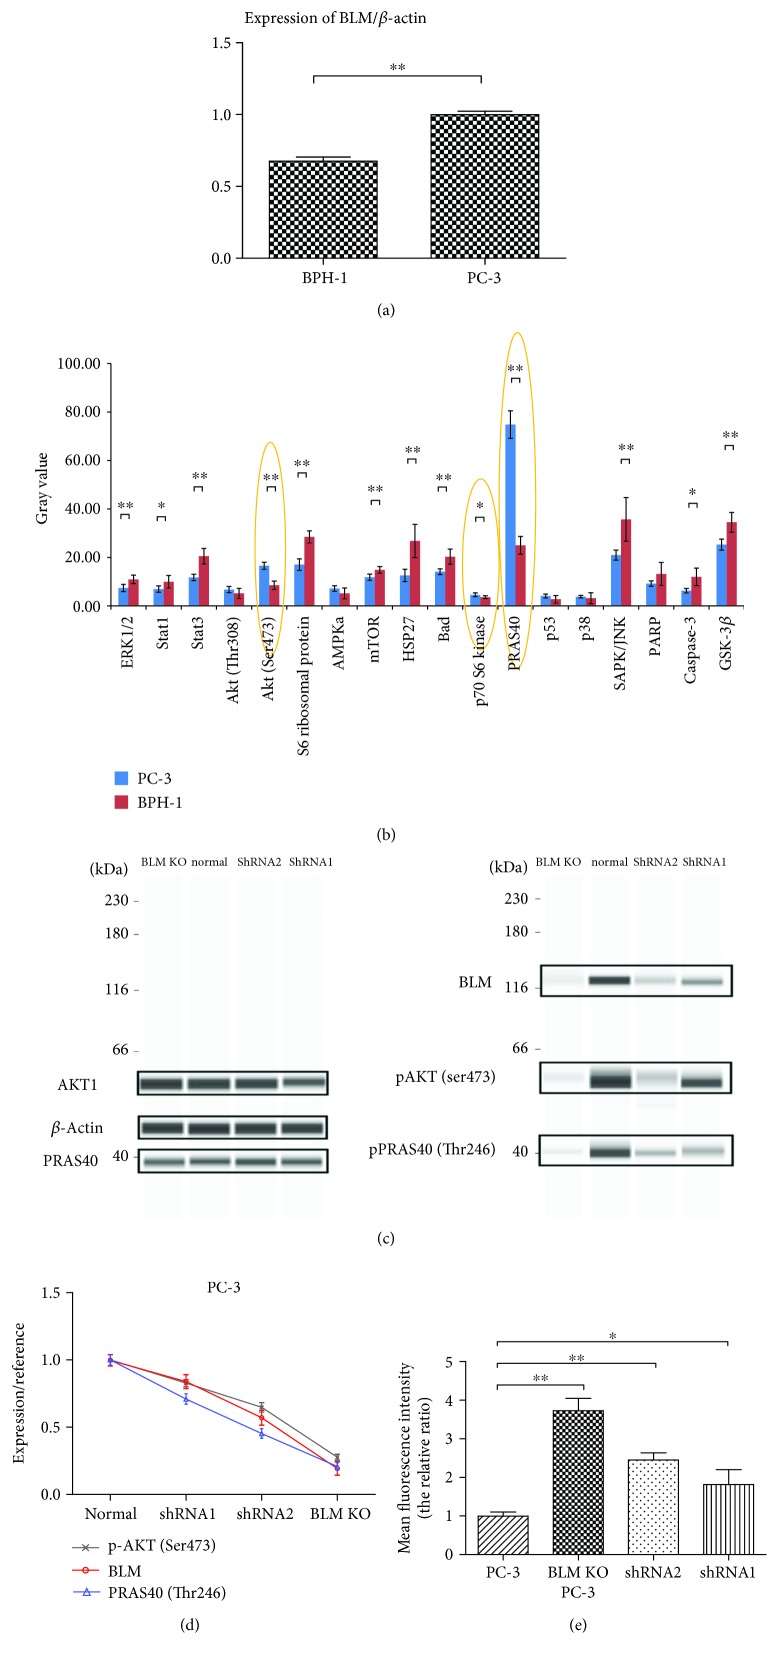
The correlation between BLM expression and phosphorylation of Akt1 and PRAS40. (a) BLM/β-actin expression in BPH-1 and PC-3 cells. BLM expression was lower in BPH-1 cells than in PC-3 cells. (b) Quantification of phosphorylated signaling proteins in PC-3 and BPH-1 cells. The levels of phosphorylated AKT (Ser473), p70 S6 kinase, and PRAS40 (Thr246) were lower in BPH-1 than in PC-3 cells. (c) BLM helicase, pAKT, and pPRAS40 expression in PC-3 cells was assessed by western blot and WES analysis. (d) Cells displayed significantly reduced BLM expression, as well as decreased levels of pAKT (Ser473) and pPRAS40 (Thr246). BLM expression values were normalized to β-actin, while pAKT and pPRAS40 (Thr246) expression values were normalized to total AKT1 and total PRAS40 expression, respectively. BLM expression was positively correlated with pAKT (P < 0.01) and pPRAS40 levels (P < 0.05). (e) Intracellular ROS levels were higher in BLM KO PC-3 cells as well as those treated with shRNA1 and shRNA2 as compared to those of PC-3 cells (mean ± SD; ∗
P < 0.05 and ∗∗
P < 0.01).